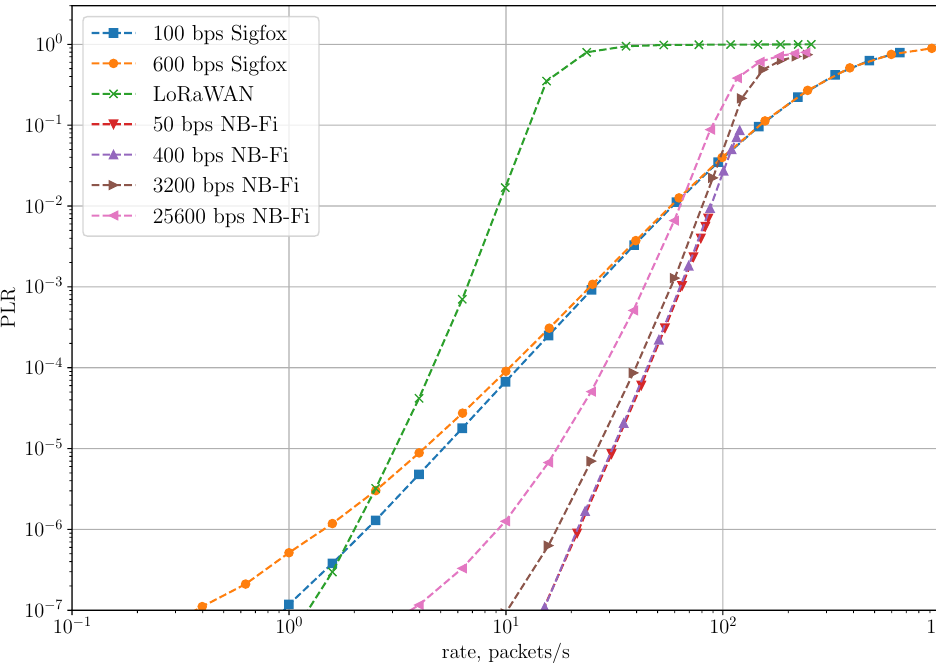
Figure 14. PLR for the reliable transmission of short packets scenario.